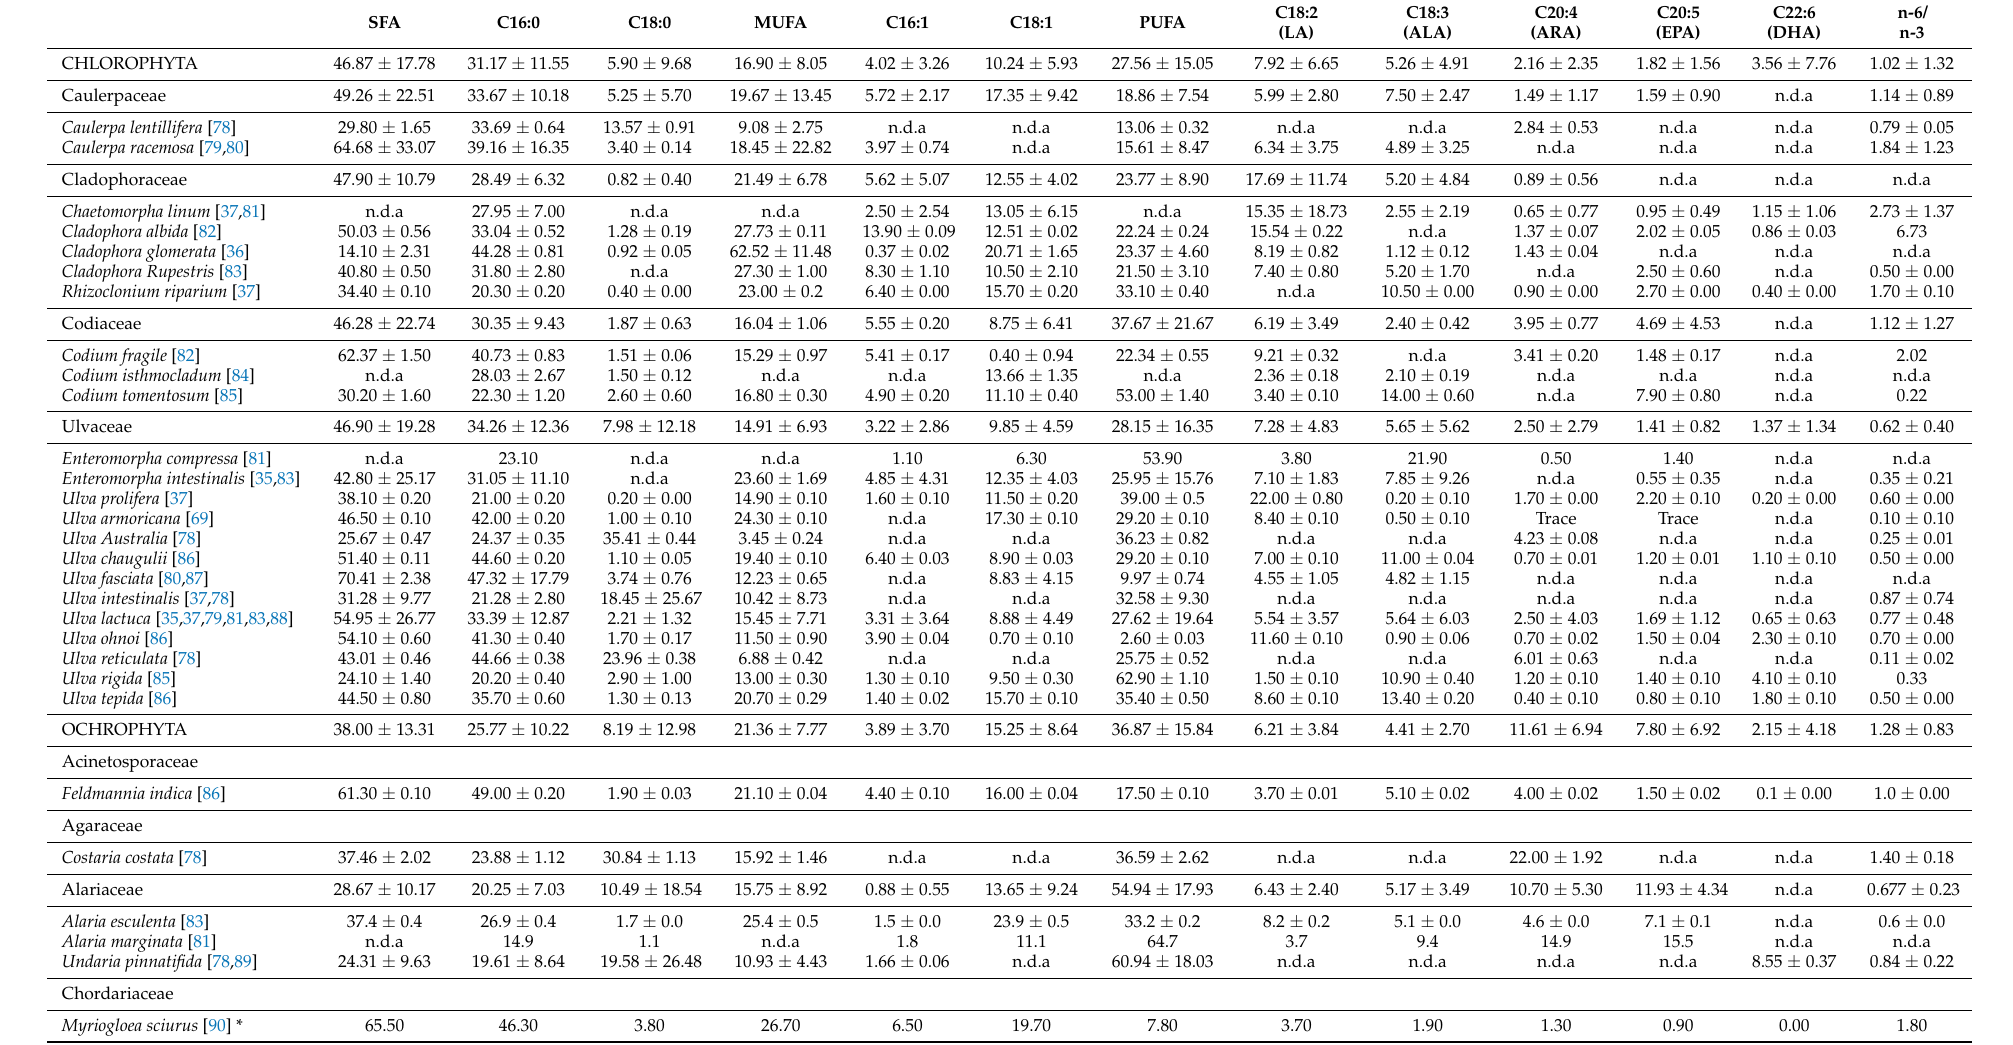
Table 1. Fatty acid composition expressed as % of total fatty acids (mean ± standard deviation (SD)) of different seaweed